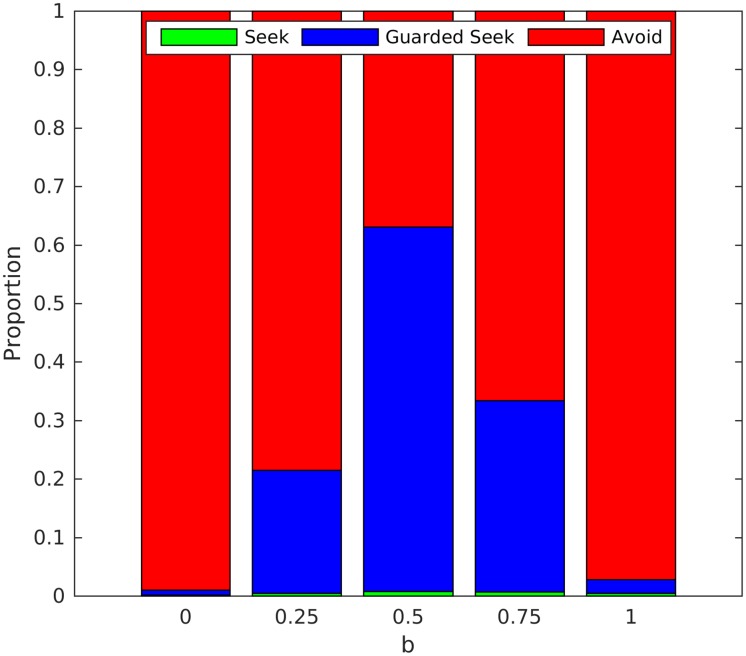
Disorganised attachment and misleading exteroceptive cues.Mean (over repetitions) proportion each action was chosen by the infant during the last 10 iterations (y-axis), when they were paired with a highly unresponsive caregiver (q = 0.05) exhibiting varying rates of misleading affective communication errors (values of b ∈ {0, 0.25, 0.5, 0.75, 1} along the x-axis, for fixed a = 1 and c = 0).